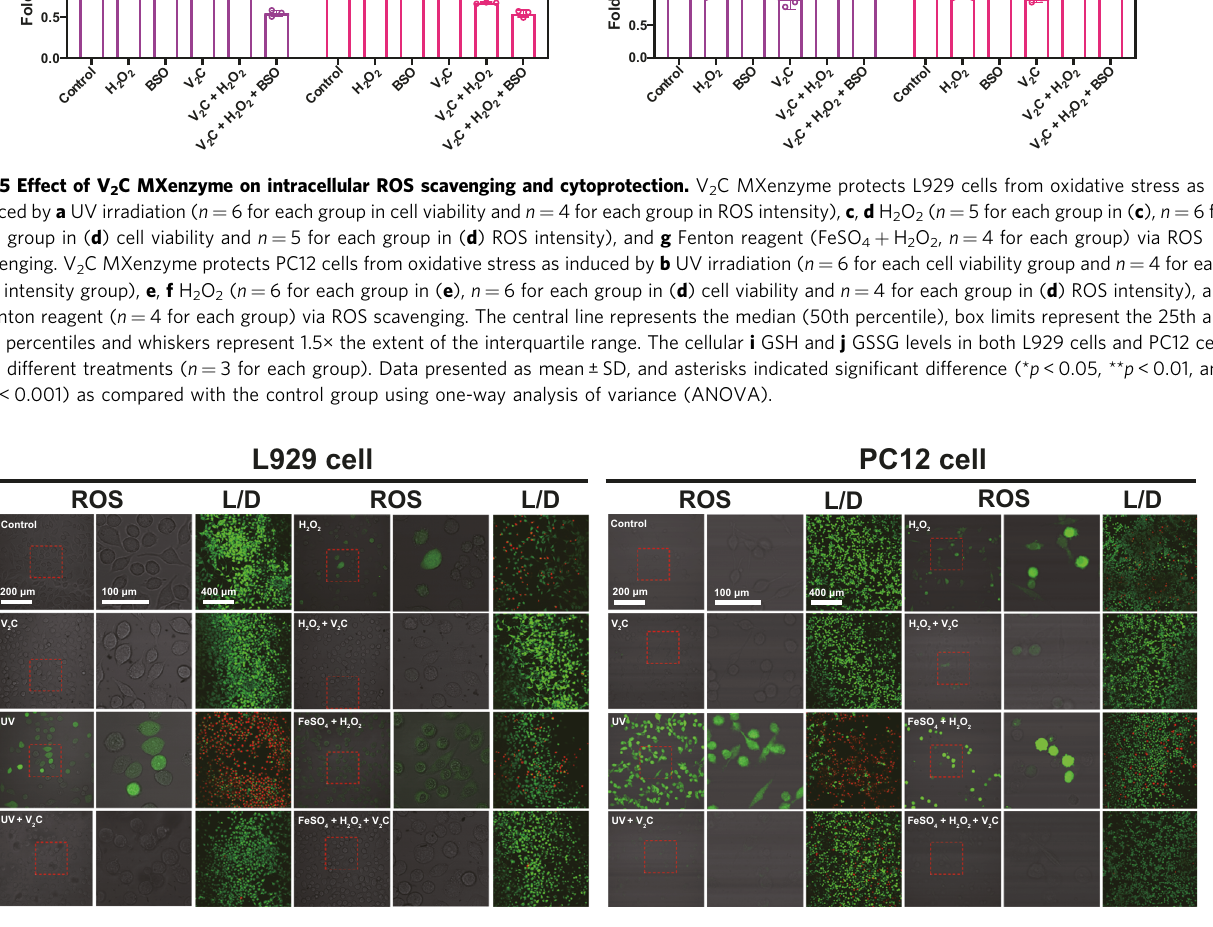
Fig. 6 Effect of V 2 C MXenzyme on intracellular ROS scavenging and cytoprotection. CLSM images of L929 and PC12 cells with different treatments stained with DCFH-DA or Calcein-AM/PI (L/D represents Live/Dead). A representative image of three replicates from each group is shown.